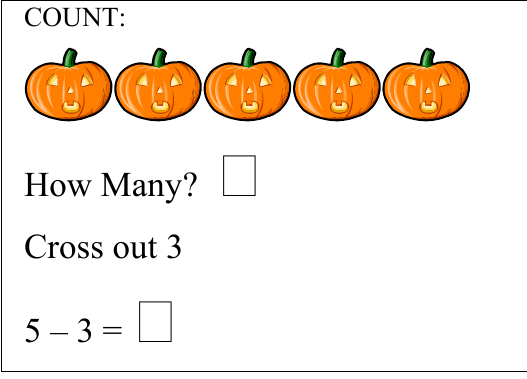
Figure 3 : Introduction of the equal sign in Successful